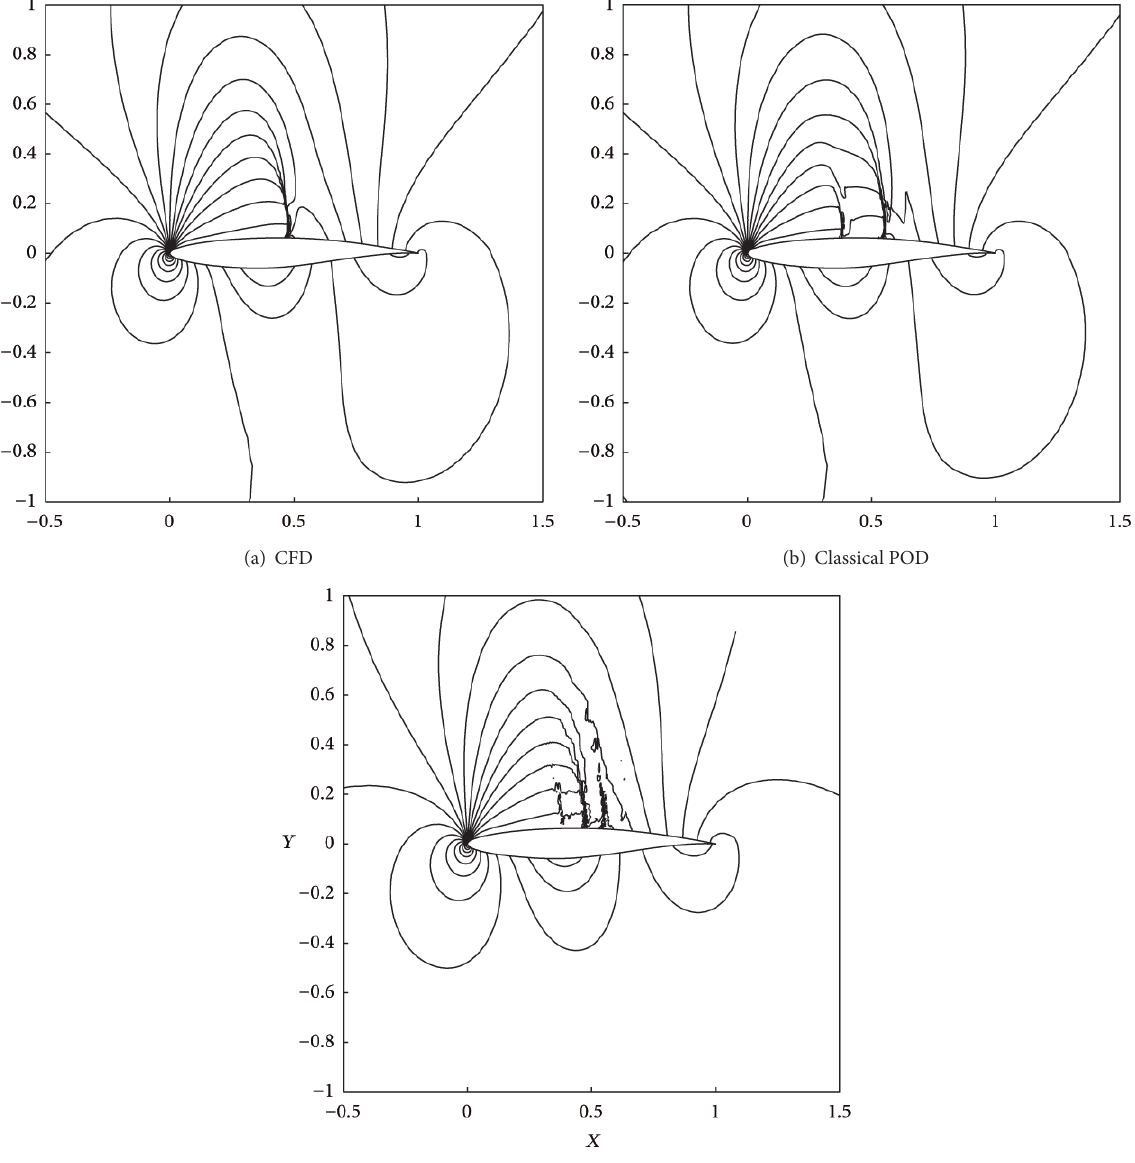
Figure 5: Comparison of the 3 contours of pressure at Mach = 0.7125 and A . O . A . = 3.125